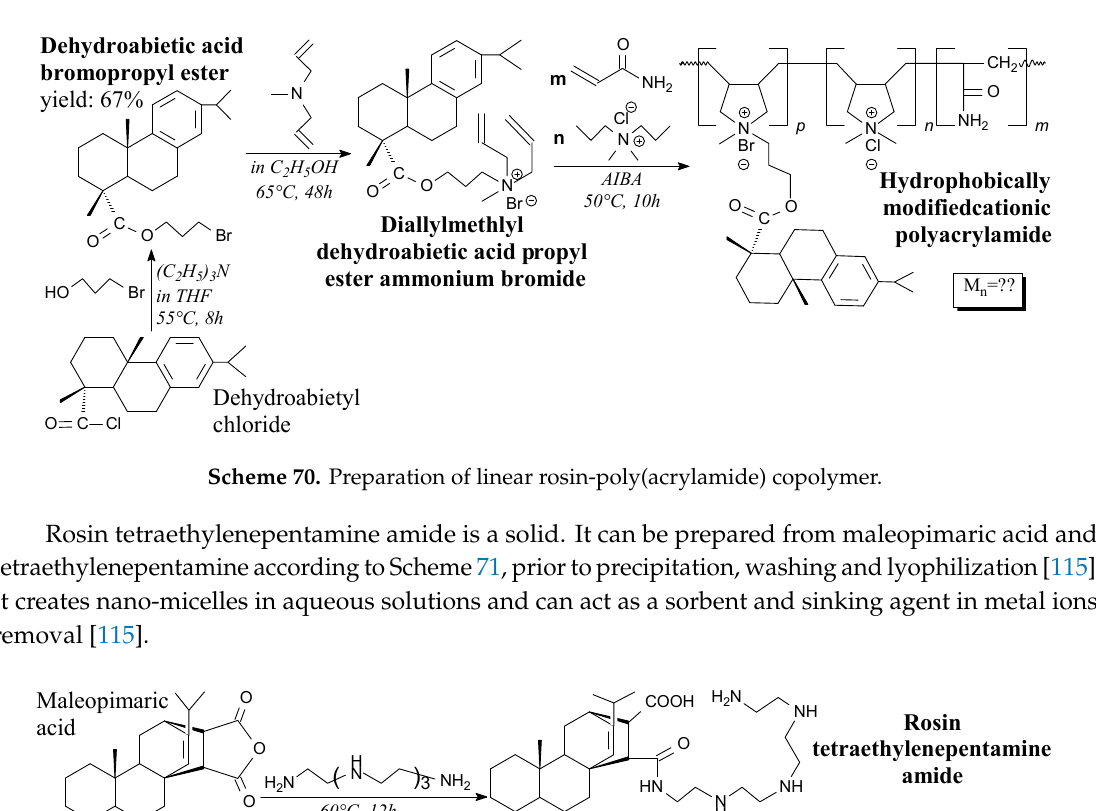
Scheme 71. Preparation of rosin-tetraethylenepentamine